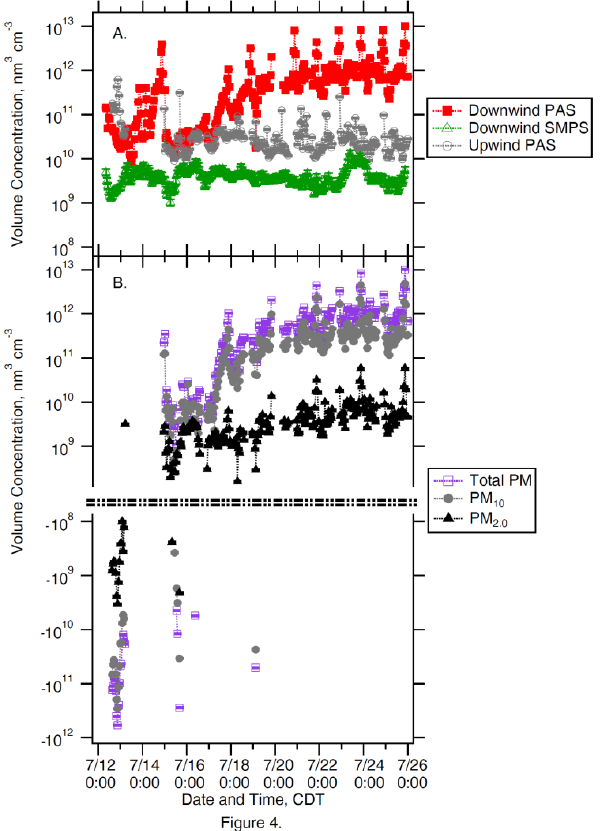
Fig. 3. Measured 24h averaged aerosol number, surface area, and volume distributions are shown in (A) , (B) , and (C) , respec- tively. Distributions measured at an agricultural site (Feedyard C, TX) on 24 July 2008, and urban site (downtown Houston, TX) on 26 September 2006, and a semi-urban site (College Station, TX) on 16 June 2006 are indicated by the solid red, solid blue, and open black marks, respectively. Within each size distribution, aerosol measured by the SMPS (0.01 to 0.5µm diameter) and the PAS (0.3 to 25µm diameter) are shown as triangles and circles, respectively. Note that both axes are in log scale.